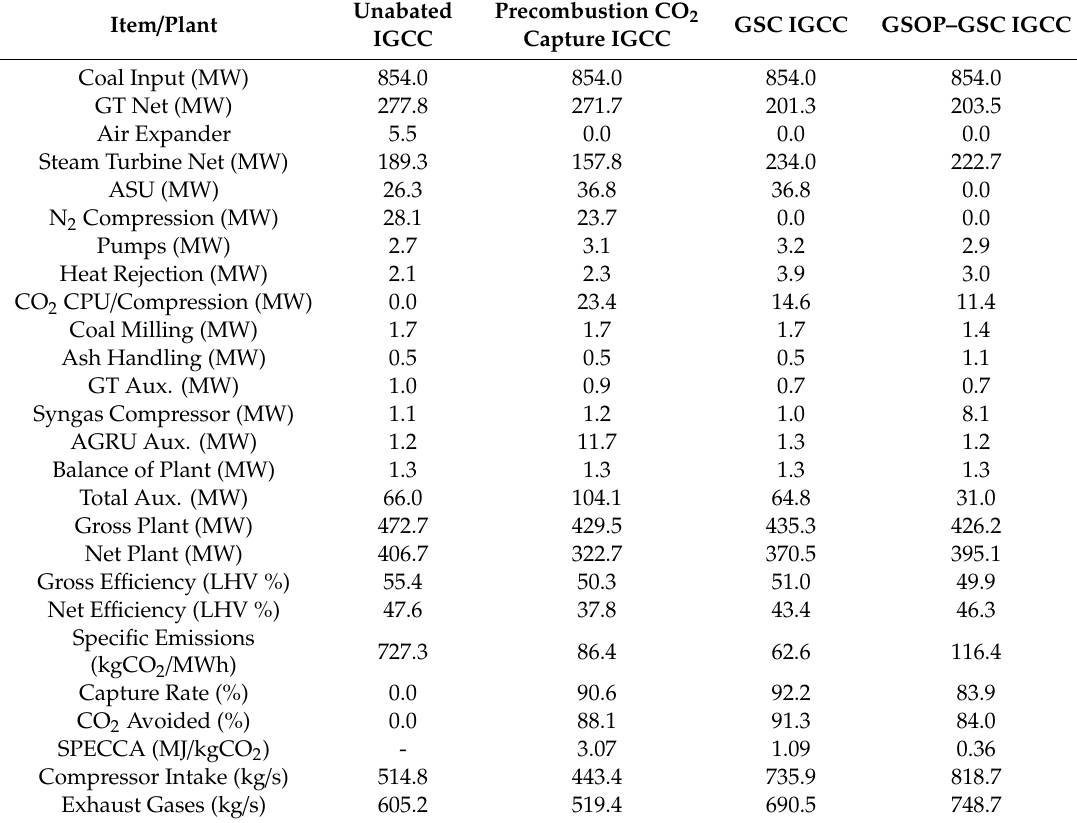
Table 1. Power plant results. ASU: air separation unit, CPU: CO 2 purification unit, GT: gas turbine, SPECCA: Specific Primary Energy Cost of CO 2